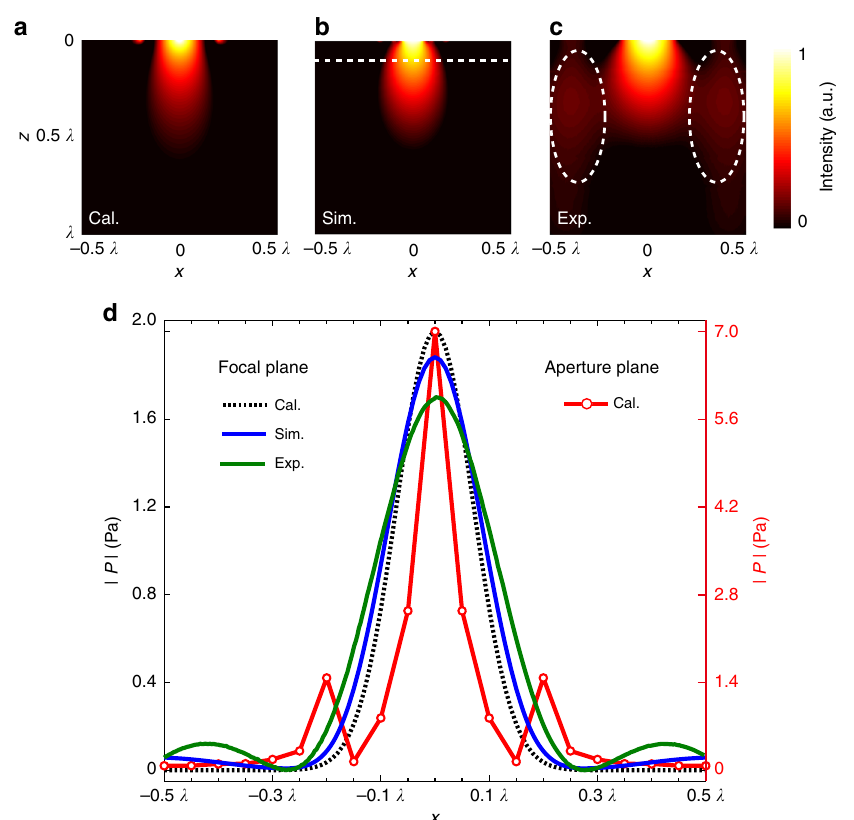
Fig. 4 Near- fi eld sub-diffraction focusing. a – c Normalized intensity distributions of the calculated, simulated, and measured pressure fi eld, showing the sub- diffraction focusing under the normal plane wave incidence. The white dashed line denotes the focal plane. The differences between the theory and the experiment are circled out. d The pro fi les of the pressure fi eld amplitude at the aperture plane ( z = 0) and at the focal plane ( z = 0.1 λ